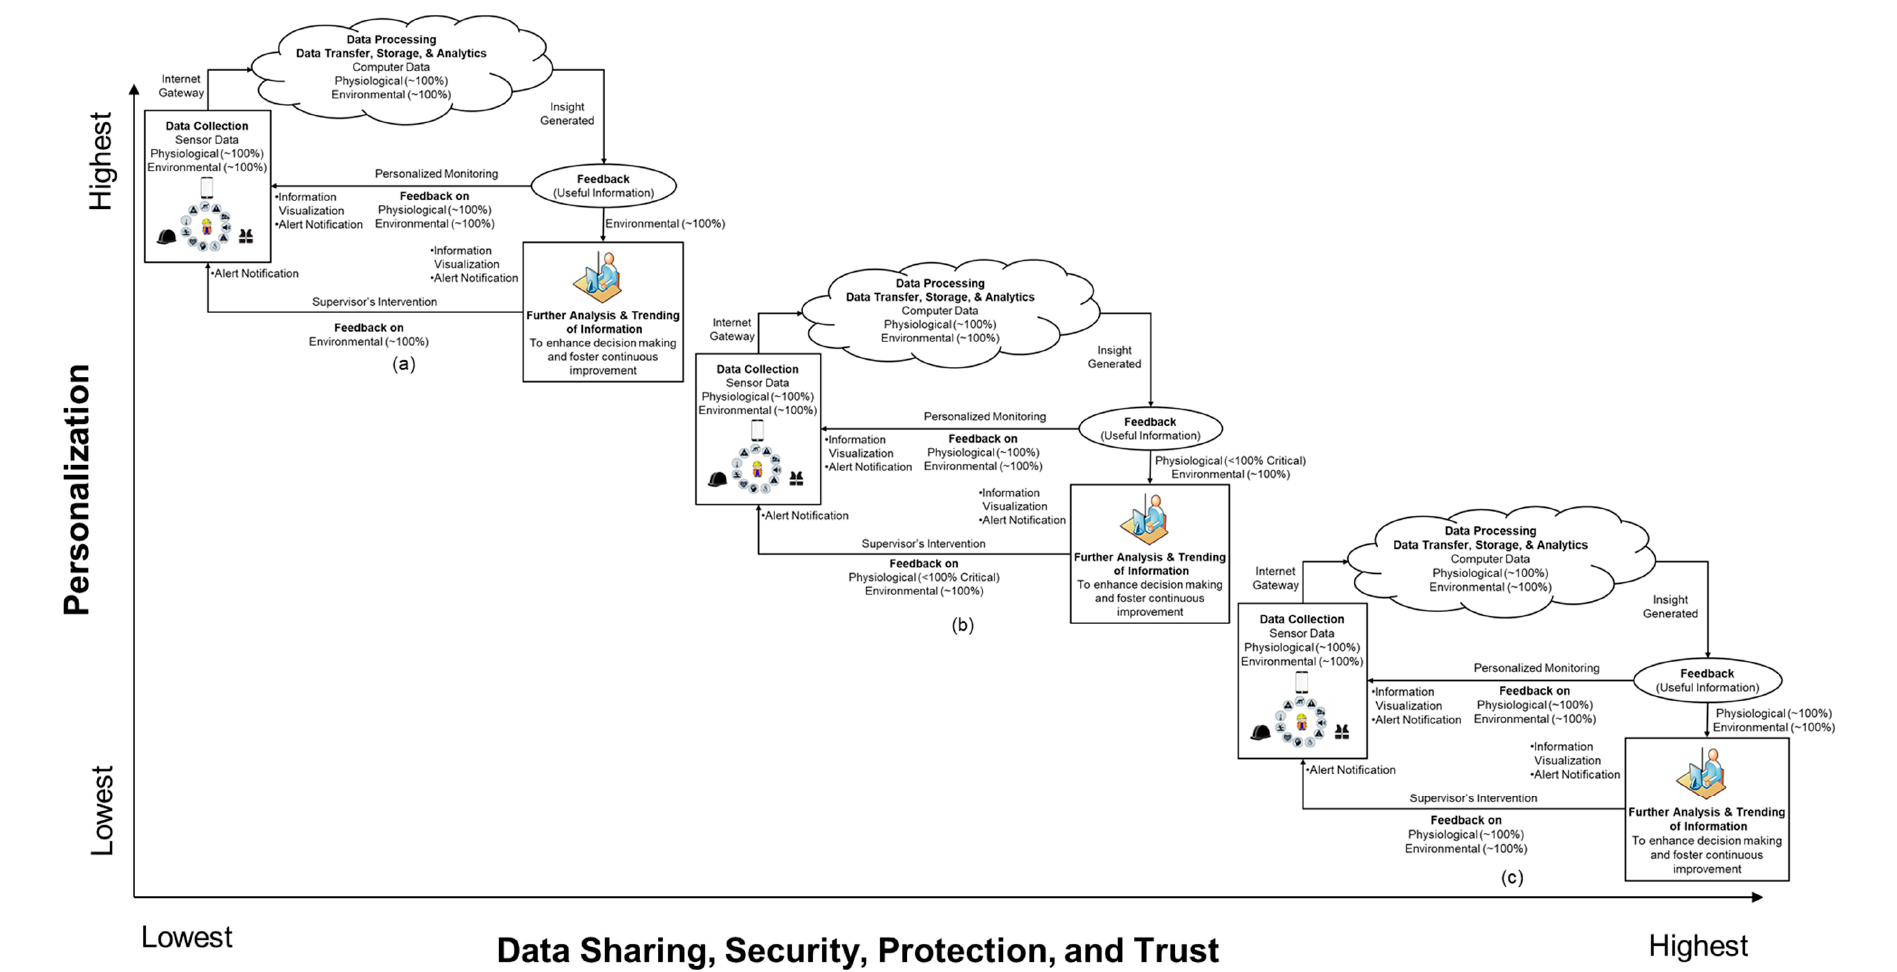
Figure 5. Framework for Personalized WSD System Transitionary Phases ( a ) limited data sharing; ( b ) increased data sharing; ( c ) 100% data sharing